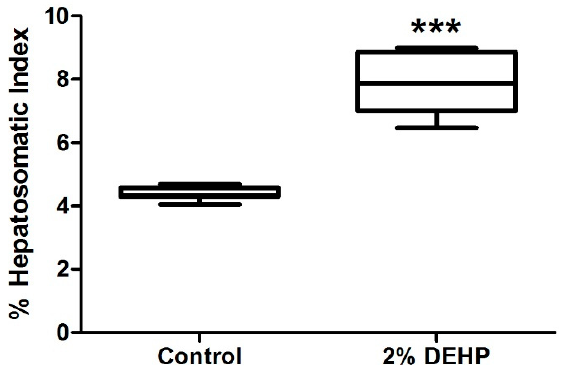
Figure 4. Effect of 2% DEHP exposure on hepatosomatic index of male Wistar rats as quantified on termination of the 14 day exposure study. Significant difference is indicated with; *** = p < 0.001.